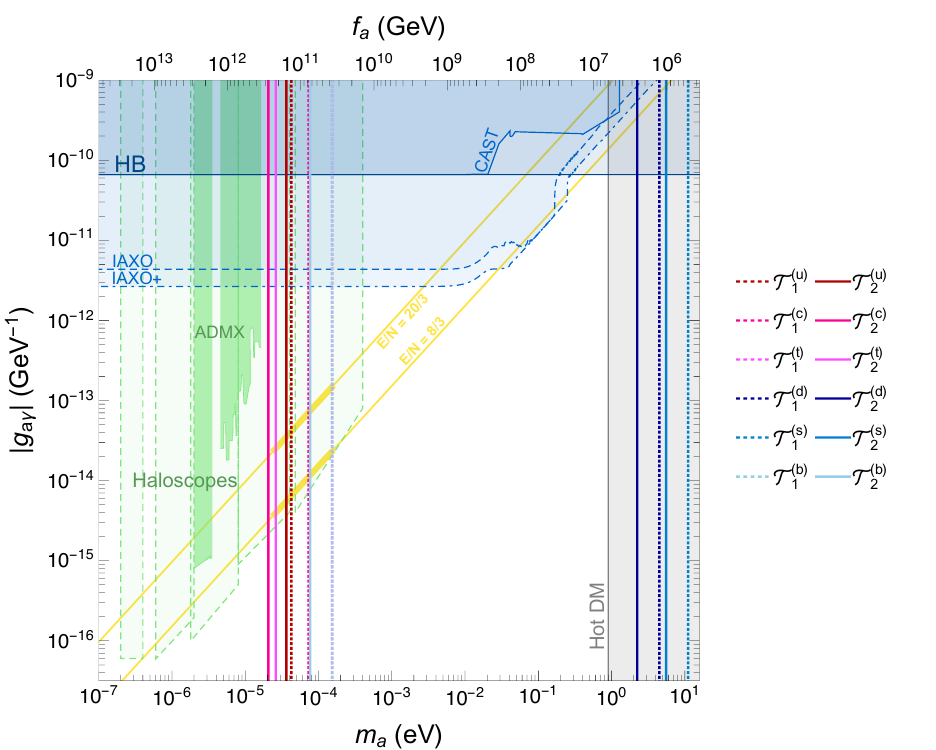
Figure 1 . Bounds on the axion-photon coupling g a(cid:13) and axion mass m a . The vertical colored lines denote the upper bound on m a from FV, for the two di(cid:11)erent textures and quark assignments. Also shown are astrophysical/cosmological bounds, and experimental sensitivities from helioscopes (in blue) and haloscopes (in green); see the text for more details. The prediction for g a(cid:13) for the models discussed in the text, in which the PQ symmetry acts also on the lepton sector, lie between the two oblique yellow lines, where the highlighted segment indicates the favored mass region for axion